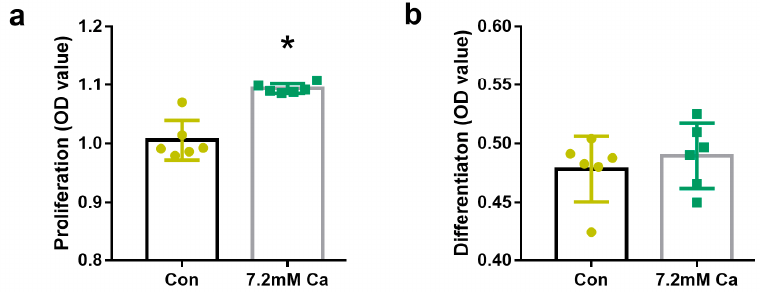
Figure 1. The proliferation and differentiation induced by extracellular 7.2 mM Ca 2+ in MC3T3-E1 cells. ( a ) The proliferation of osteoblasts. * p < 0.05, vs. Con group. ( b ) The differentiation of osteo- blasts.